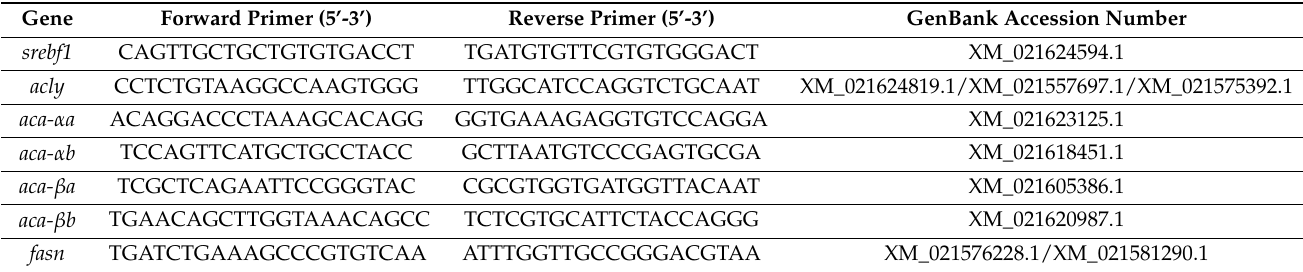
Table 5. Primer sequences and accession numbers for qPCR analysis of the de novo lipogenesis pathway.